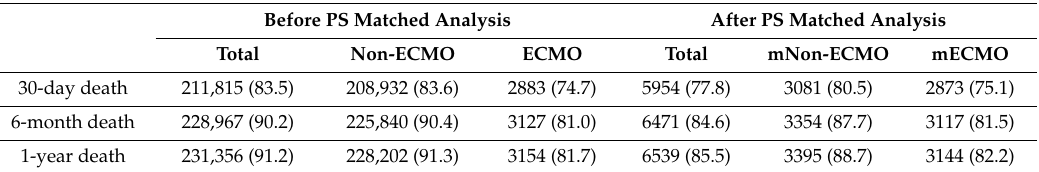
Table A1. The 30-day, 6-month rate, and 1-year mortality rates before propensity score matched analysis and after propensity score matched analysis.